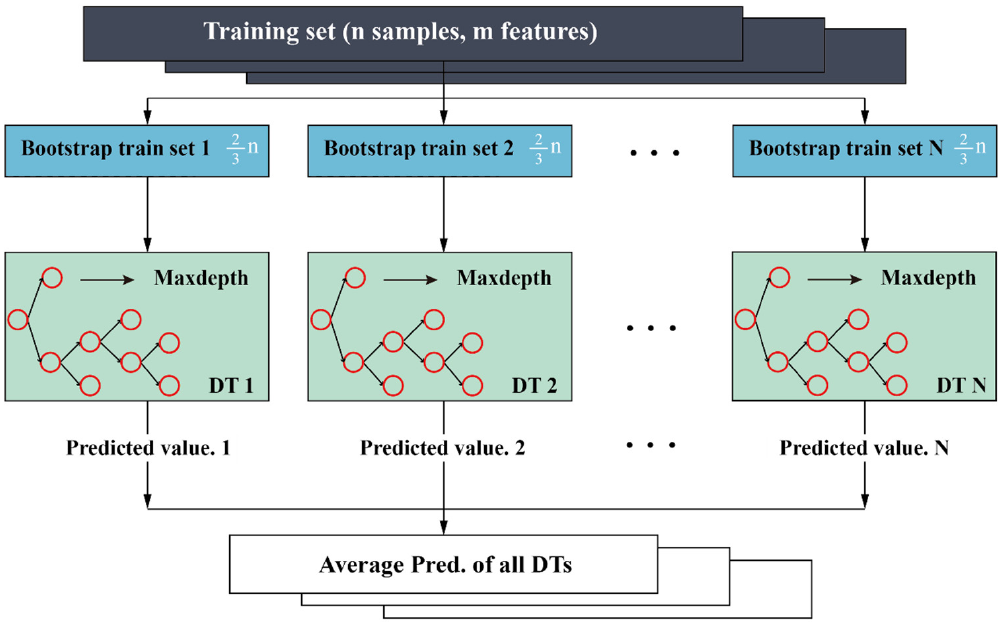
Figure 3. The common structure of the RF model in the regression problem.